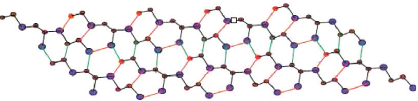
− II [ p, q ] for p � 5, q � 1. C 2 3